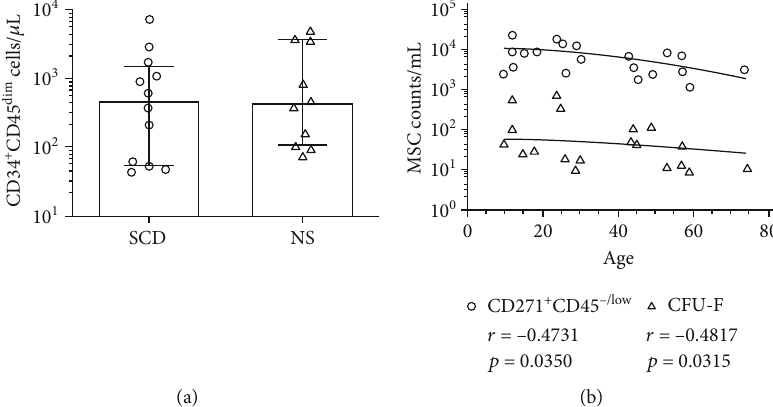
Figure 3: Quanti fi cation of hematopoietic progenitors in BM-MNC and correlation of MSC with donor age. (a) Counting of CD45 dim CD34 + cells in BM-MNC. (b) Correlation between putative MSC (either CFU-F frequency or CD271 + CD45 -/low cell counts) and increasing donor age. A Spearman r test was used for the correlation analysis independent of osteoarticular complication. Black and dashed lines across data sets indicate of best fi t for each group. Statistical analyses (Mann – Whitney U test) were performed between values, and the data are reported as the median and interquartile